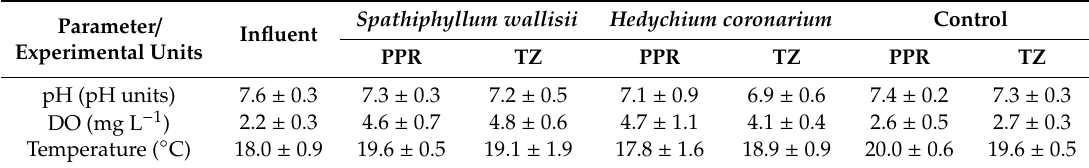
Table 2. pH, dissolved oxygen and water temperature. Mean values ± standard error (n = 156).